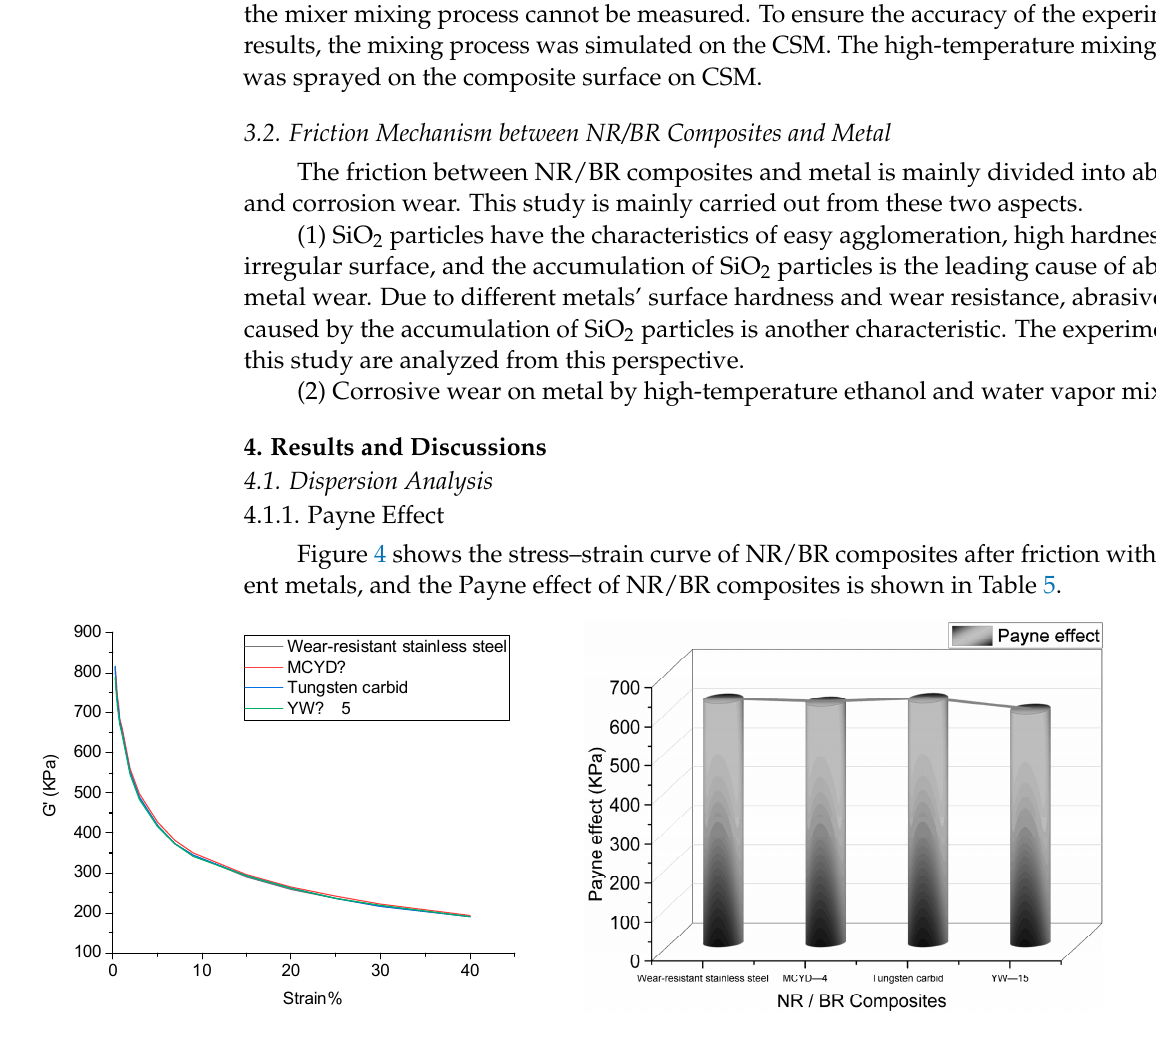
Figure 4. Payne effect of NR/BR composites after friction with different metals. Table 5. Payne effect of NR/BR composites after friction with different metals.